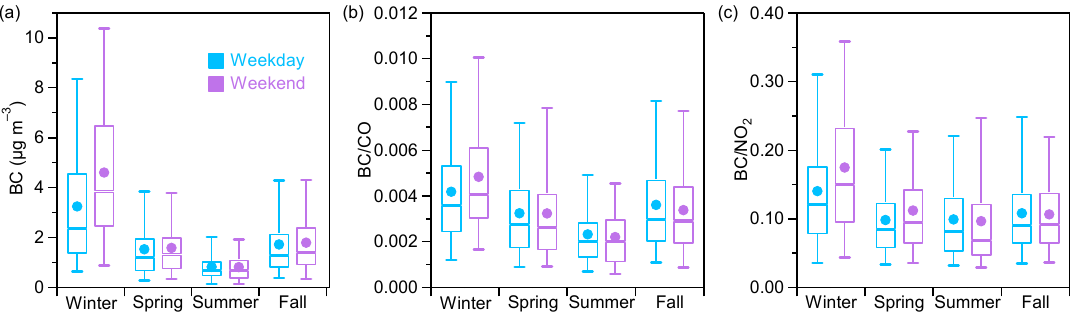
Figure 5. Comparison of ( a ) BC concentration, ( b ) BC/CO ratio, and ( c ) BC/NO 2 during the weekday and weekend in different seasons, respectively.